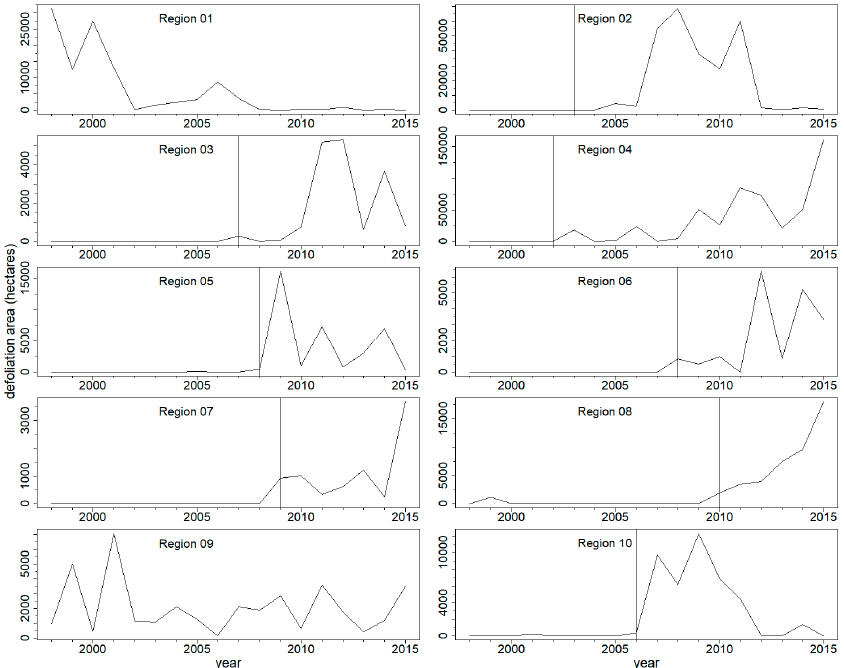
Figure 2. Adjusted defoliation area (ha) time series of regions used in the study. Vertical black lines indicate the initiation year used in the superposed epoch analysis. Because an outbreak was already ongoing in the first year of defoliation data (1997), Regions 1 (Washington) and 9 (Northern New Mexico) do not have initiation years. Generally, regions in the Northwest received more precipitation (434–1588 mm per year) than the Southwest (319–930 mm per year) (Figure 3). Region 5 (533 mm per year), was an exception: it is in the Northwest and also the driest region. Mean annual temperatures ranged from 3.3 °C to 8.2 °C in the Northwest, and 4.0 °C to 9.9 °C in the Southwest. Region 10 was the warmest region (9.0 °C), due in part to its southernmost location.